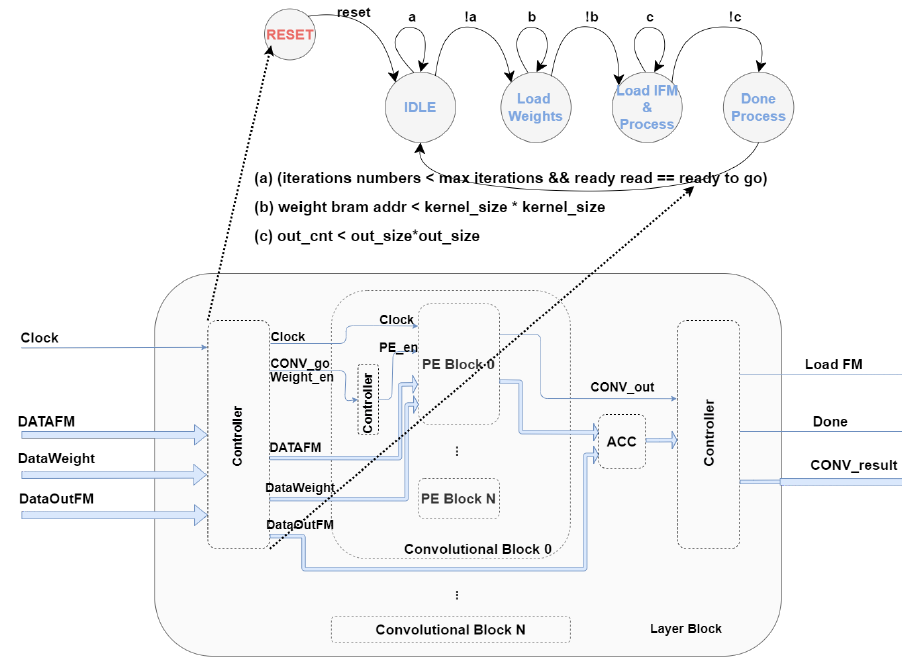
Figure 5. State machine diagram with stages